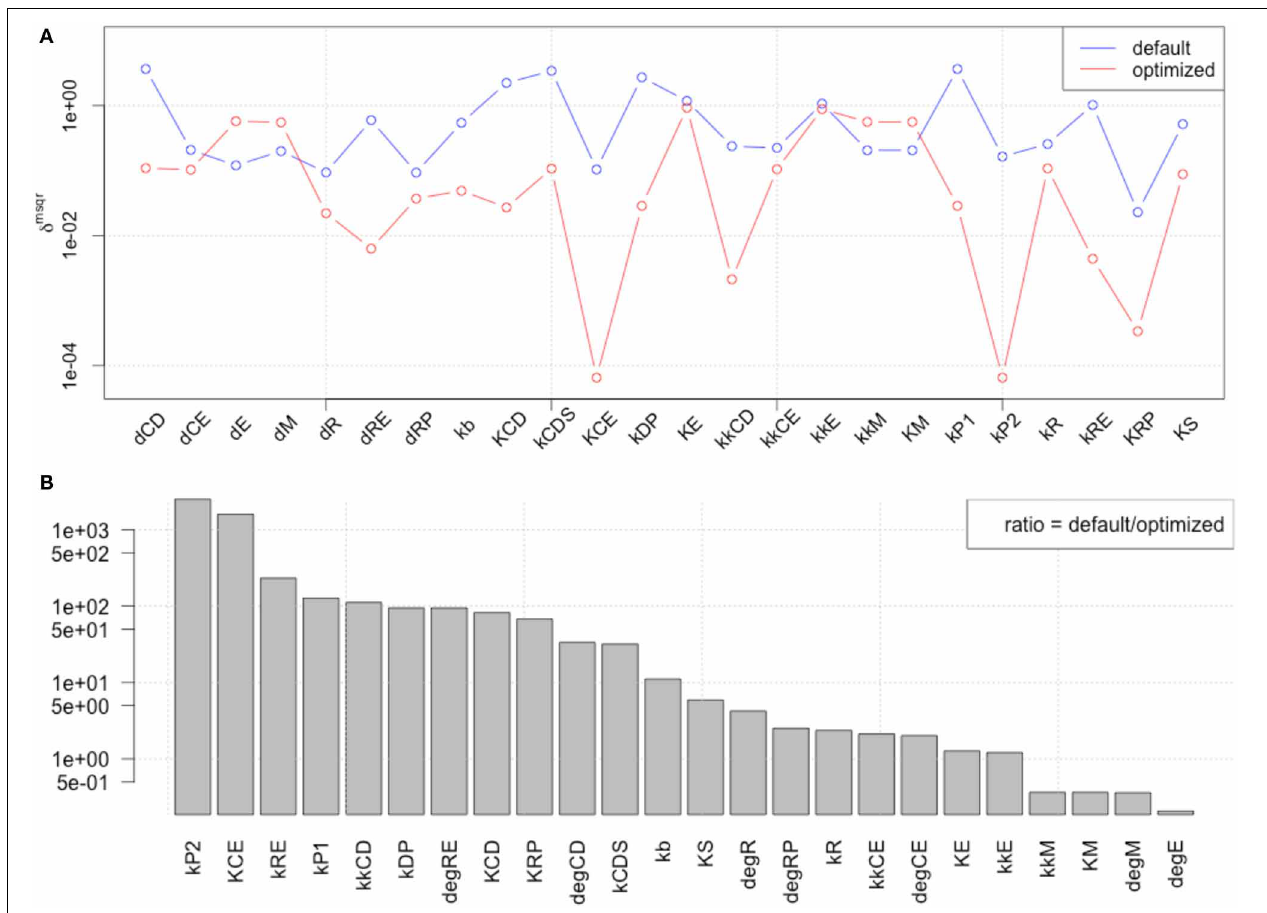
FIGURE 3 | Comparison of local parameter rank of the original parameter set with the 1st set of optimized parameters. (A) The graph shows the rd msqr of the original and 1st set of 24 optimized parameters. The blue line indicates the result of local sensitivity analysis with the original parameter set, and the red line indicates the result with the optimized parameter set. (B) Visualization of the changes in local